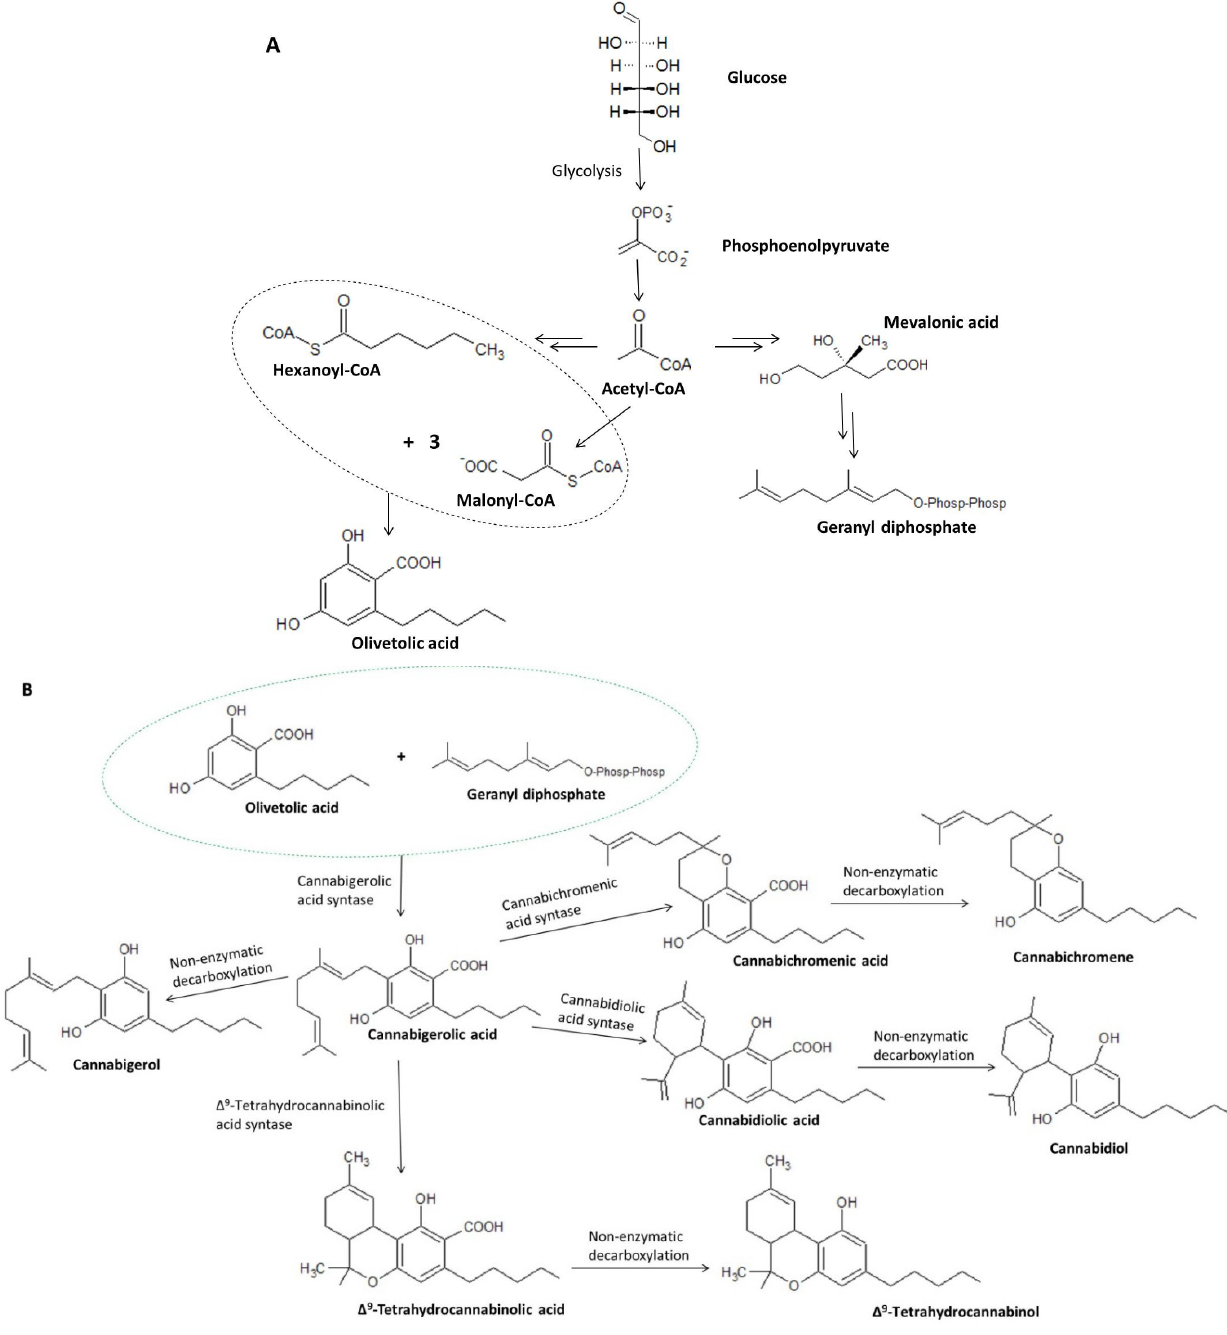
Figure 4. Biosynthesis of olivetolic acid and geranyl diphosphate ( A ) and their further transfor- mations leading to the formation of cannabigerolic acid, including the conversion of CBGA to cannabigerol, cannabidiolic acid, cannabichromenic acid, and Δ 9 -tetrahydrocannabinolic acid ( B )